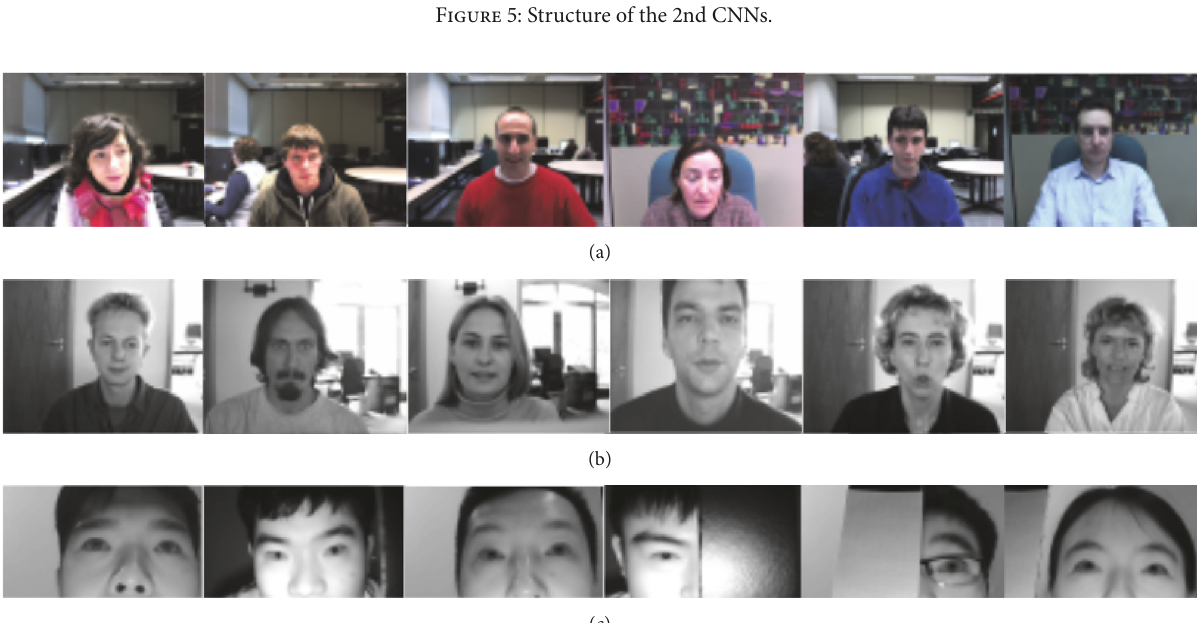
Figure 6: Samples of images in the datasets. (a) shows samples from GI4E datasets and (b) is from BioID datasets, while (c) is from our datasets. Note the significant variation in illumination, head position, infrared/visible image, and full/half covered face.